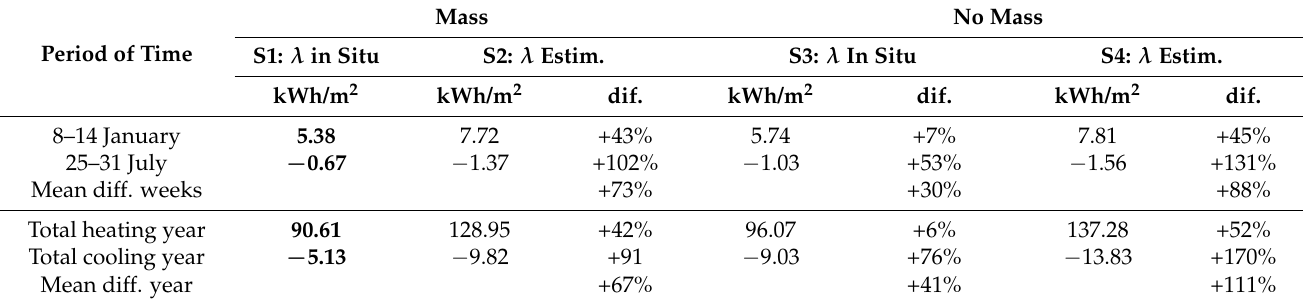
Table 10. Energy demand (kWh/m 2 ) of the room in S1–S4. % Difference between S1 and the rest of alternatives.